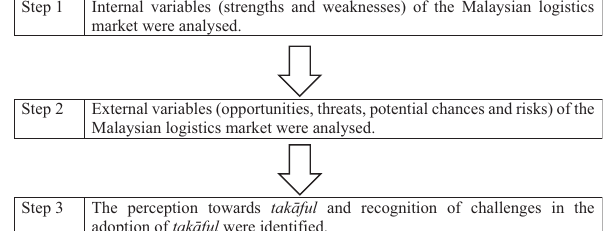
Figure 1. Three steps of content